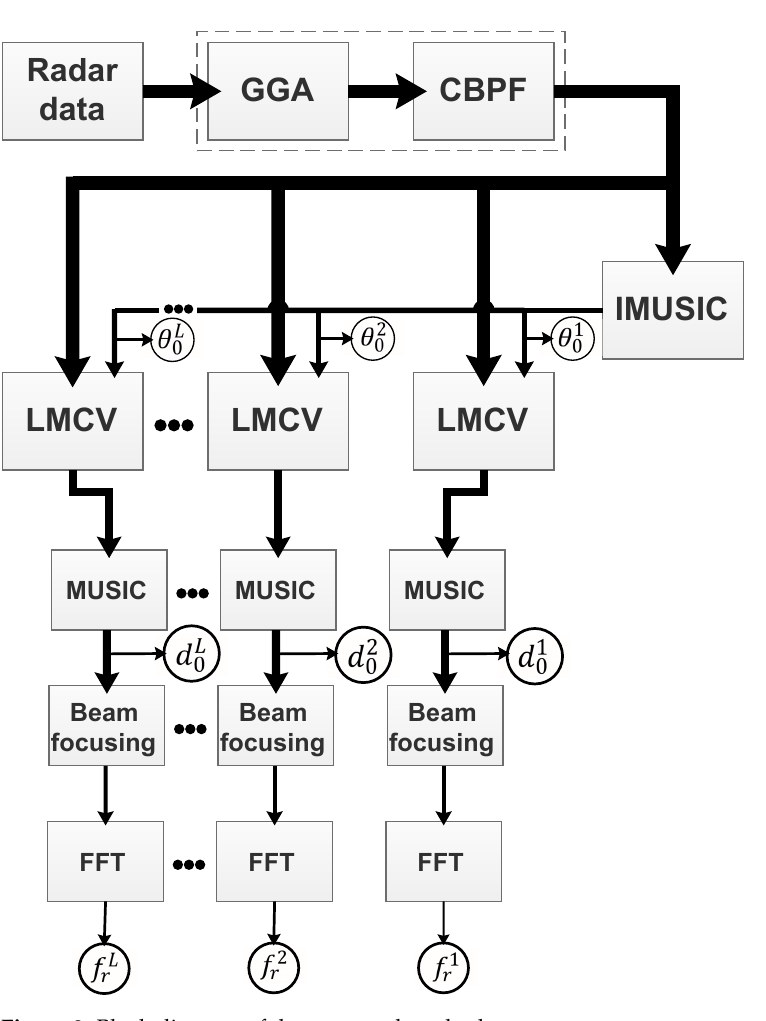
Figure 3. Block diagram of the proposed